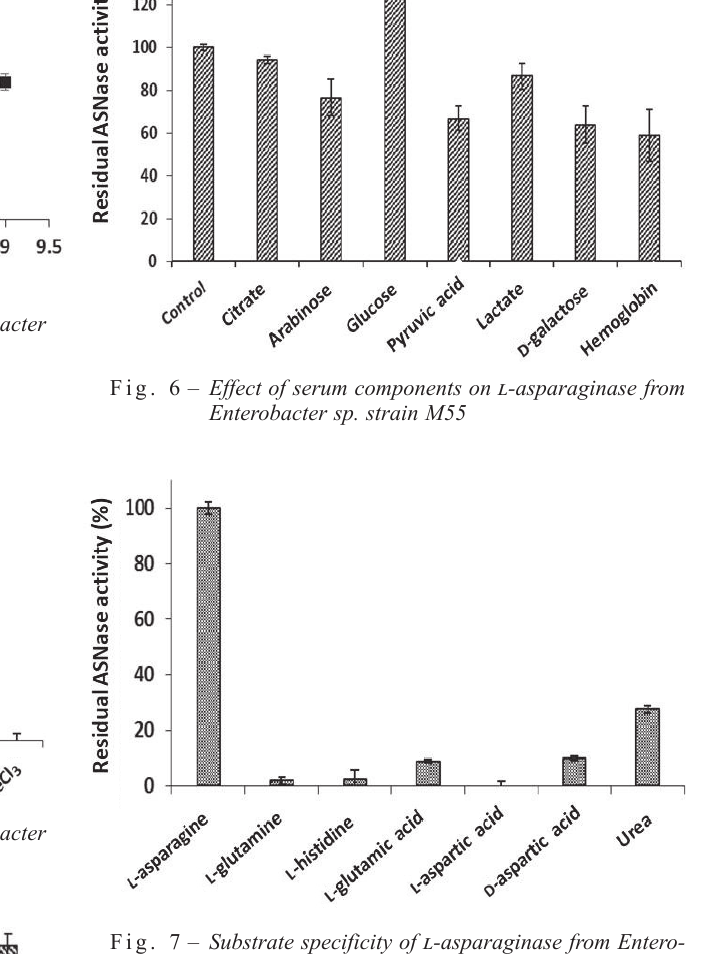
Fig. 7 – Substrate specificity of l -asparaginase from Entero- bacter sp. strain